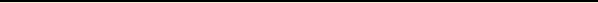
Table 1 Timeline of COVID-19 vaccination program in Hong